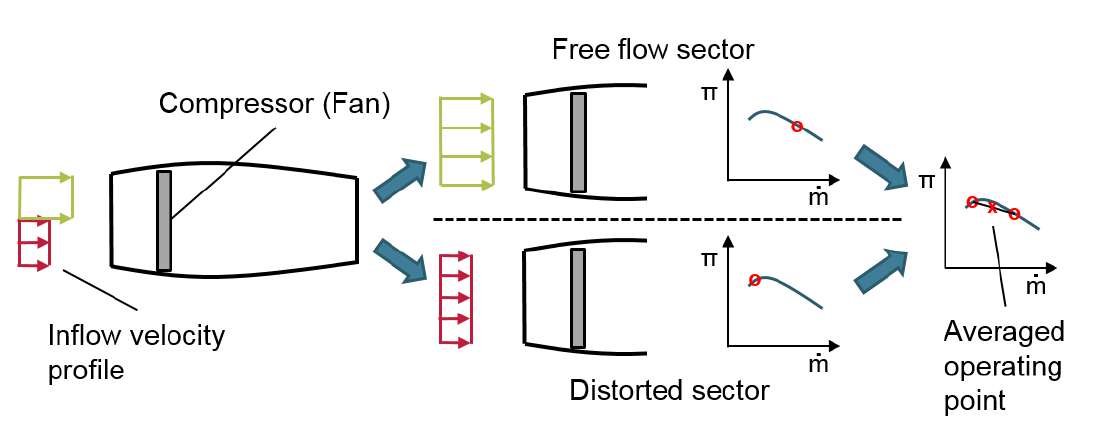
Figure 3. Functional principle of the parallel compressor model.